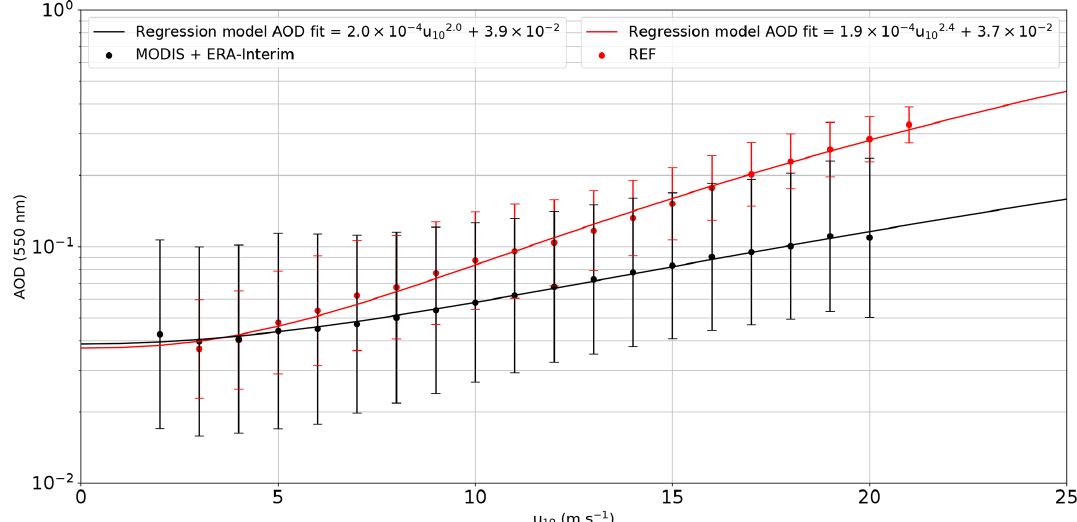
Figure 4. Binned AOD at 550nm vs. 10m wind speed. Daily averages of AOD were matched to 10m wind speeds for all ocean grid cells at latitudes between 40 and 60 ◦ S for July 2003–2007. These values were then sorted into discretised 1ms − 1 bins, and the median AOD in each bin was recorded. Grid cells were considered individually during the binning process (i.e. AOD and wind speeds were not averaged zonally prior to binning). A least-squares regression was performed on the gridded data, and the fit is shown for the REF simulation and ERA-Interim and MODIS data between 2003 and 2007. Days on which there were less than five MODIS observations of AOD in a given 0 . 5 ◦ × 0 . 5 ◦ grid cell were removed from the